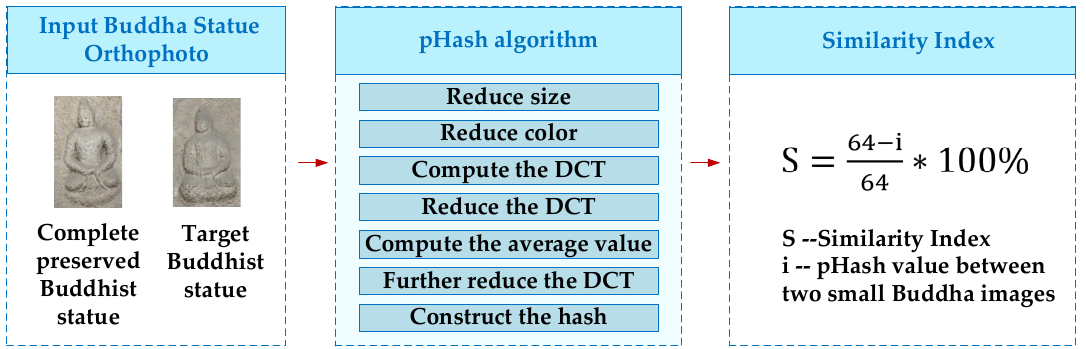
Figure 6. Flow chart of pHash algorithm.